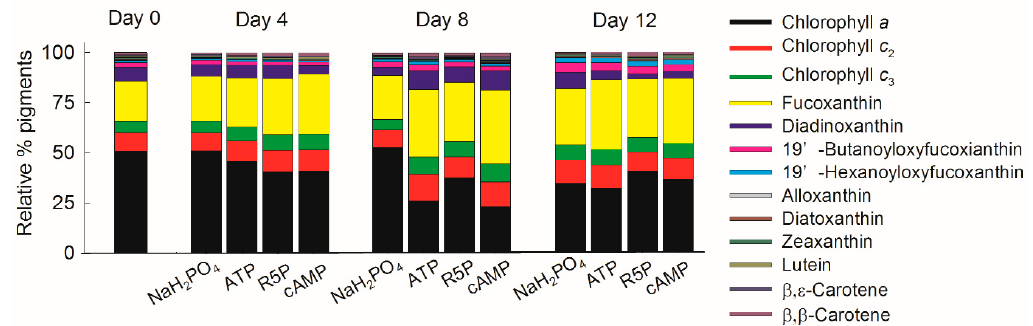
Figure 7. Pigment composition of Karenia mikimotoi in the NaH 2 PO 4 , adenosine triphosphate (ATP), ribulose 5 ‐ phosphate (R5P), and cyclic adenosine monophosphate (cAMP) treatments on days 0, 4, 8, and 12.